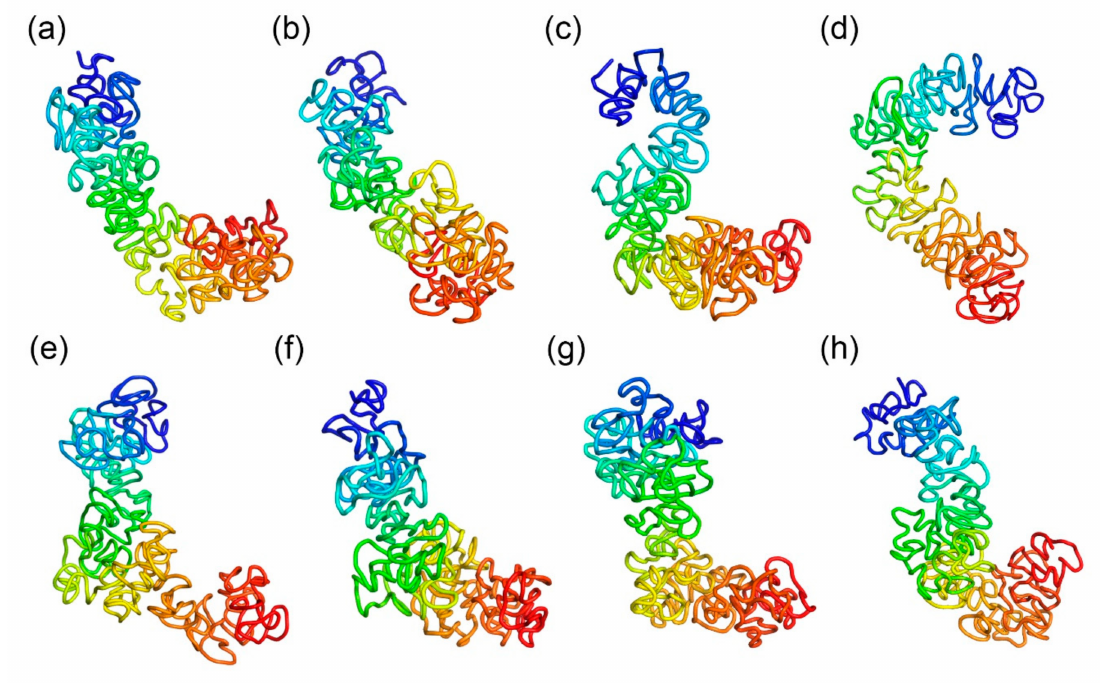
Figure 2. ( a – d ) are the 3D structures of the X-chromosome of a TH1 cell when r m in Equation (3) equals 8.976 and n in Equation (3) equals 1, 2, 3, and 4, respectively. ( e – h ) are the 3D structures of the X-chromosome of a TH1 cell when r m in Equation (3) equals 8 and n in Equation (3) equals 1, 2, 3, and 4,